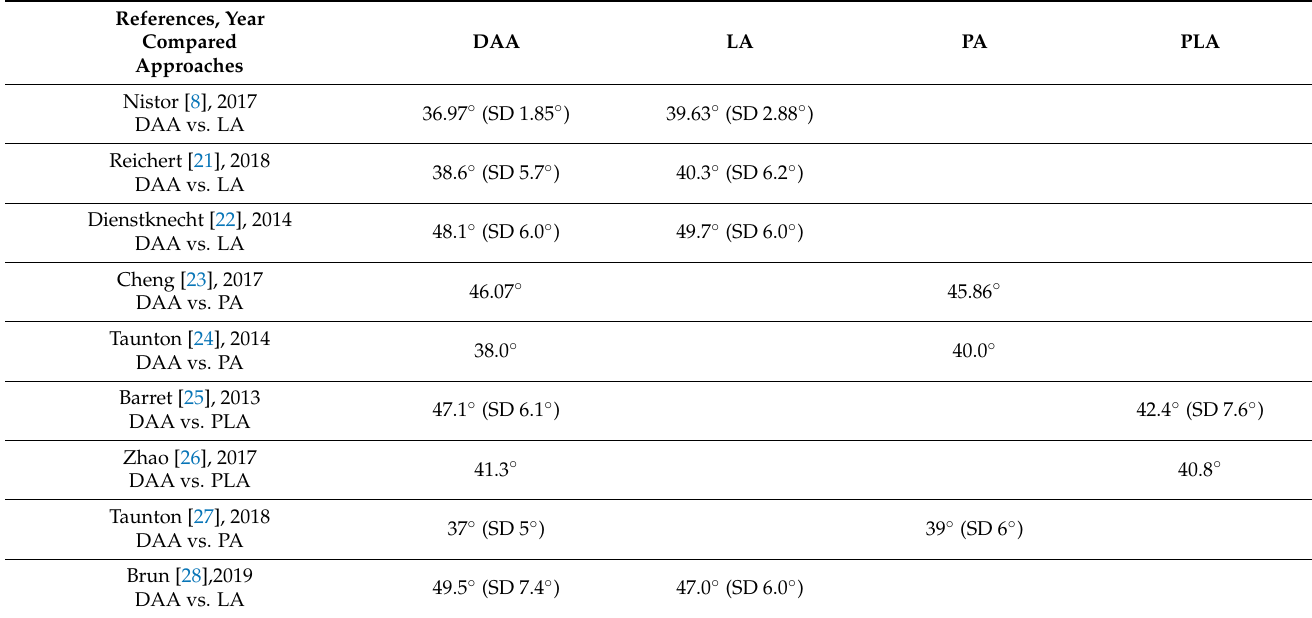
Table 5. Mean radiographic cup inclination angles in analyzed studies.